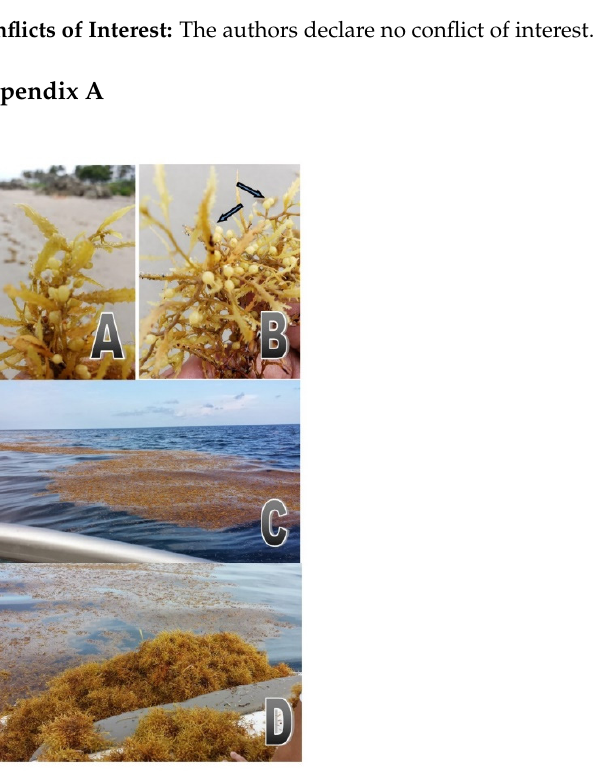
Figure A1. ( A ) indicates Sargassum fluitans. Notice smooth pneumatocysts (air bladders). ( B ) indicates Sargassum natans . Arrows indicate spines typically associated with pneumatocysts of this species. ( C , D ) show algal mats accumulating at sea surface and collected mats ( D ). Typically mats consist of both species shown in ( A , B ).